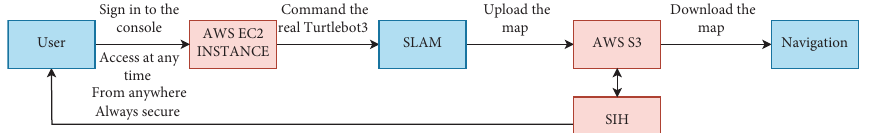
Figure 9: Scenario process.